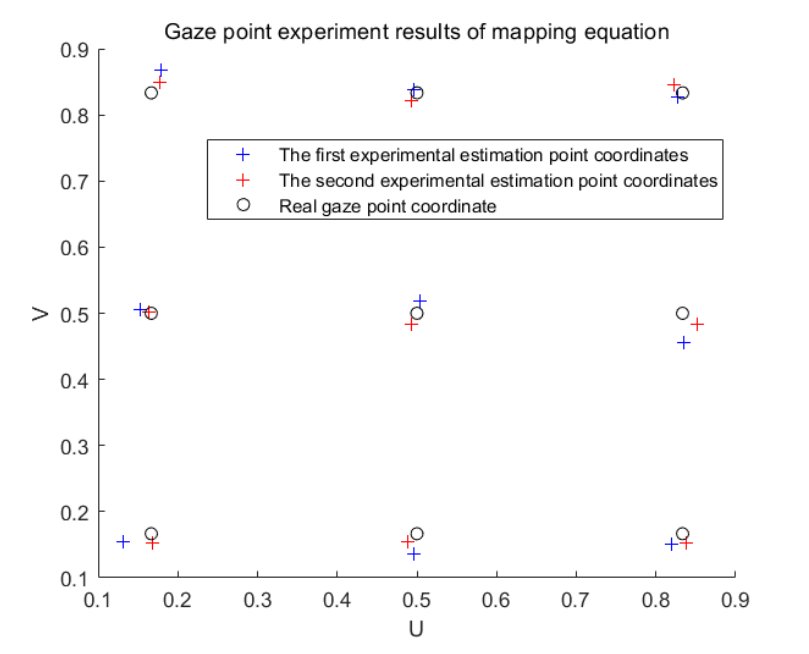
Figure 7. Nine-point verification results of the mapping